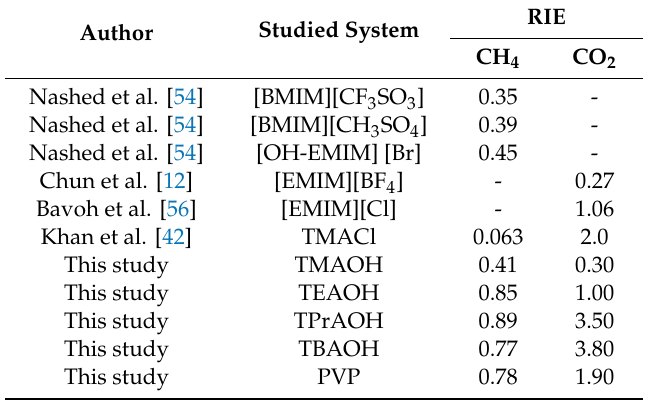
Table 3. The comparisons of RIE data for 1 wt.% CH 4 / CO 2 -ILs